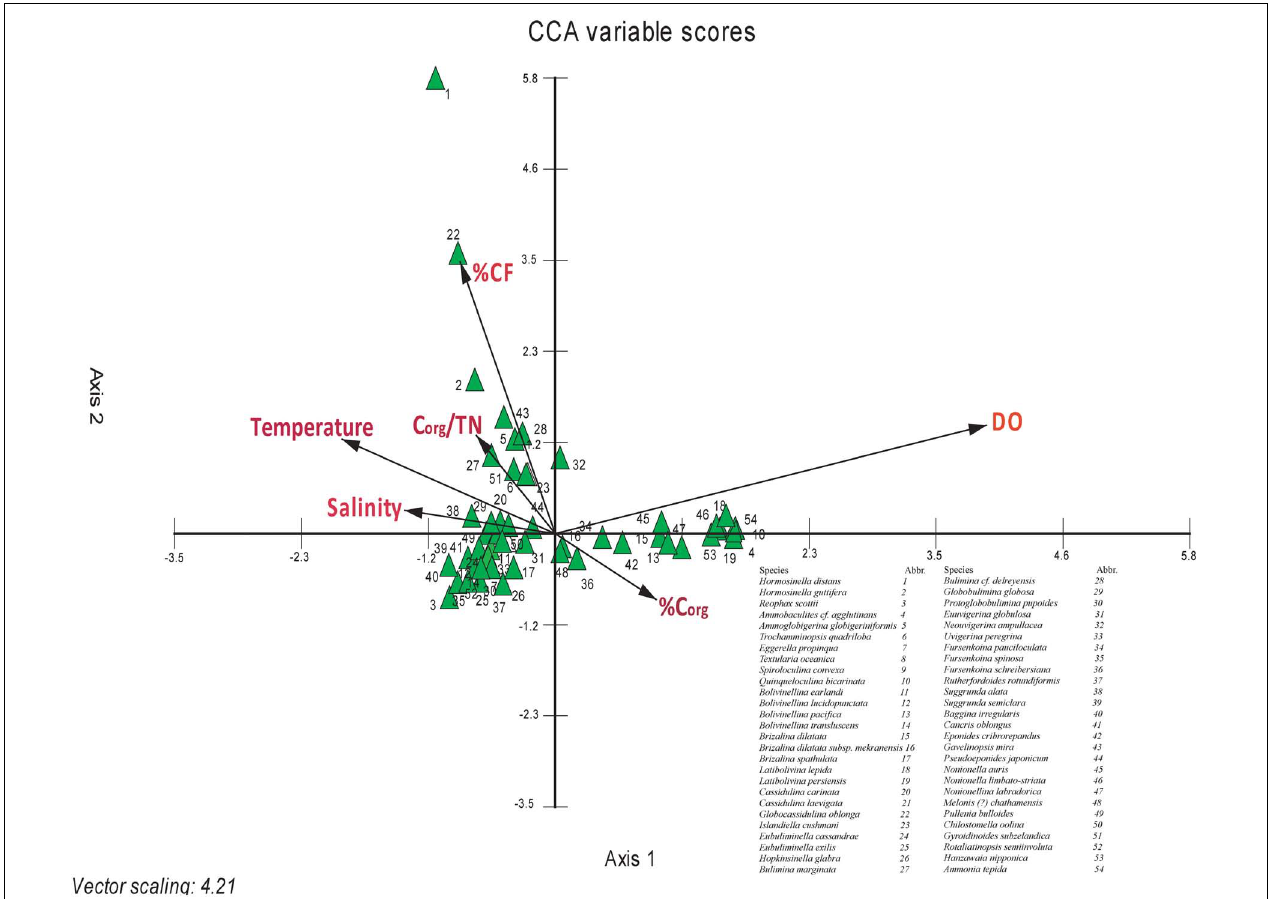
FIGURE 9 | Canonical correspondence analysis (CCA) between species abundance and environmental parameters. The arrows represent environmental parameters-C org , organic carbon; C org /TN, organic carbon/total nitrogen; CF, coarse fraction; DO, dissolved oxygen; T, temperature; S, salinity; D, depth. The triangles represent the species (modified from Suokhrie et al., 2020).